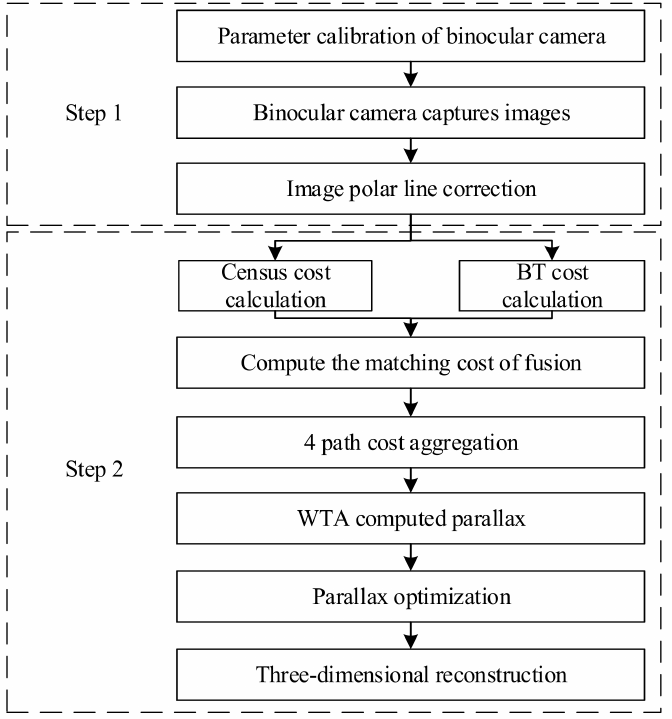
Figure 1. Algorithm flow chart of this